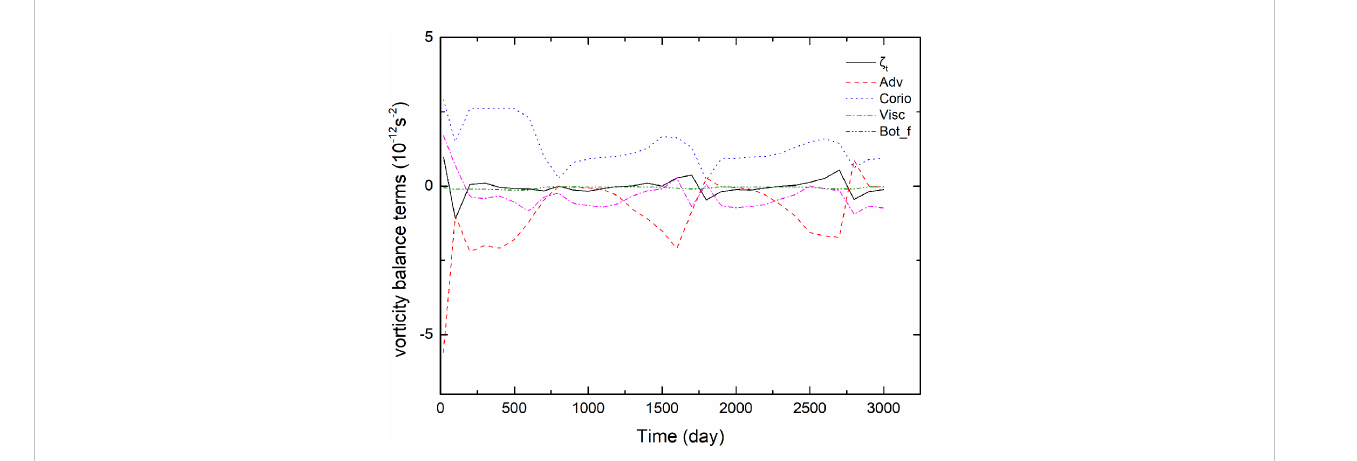
FIGURE 12 Same as Figure 10, except for the anticyclonic eddy – WBC interaction. WBC, western boundary current.